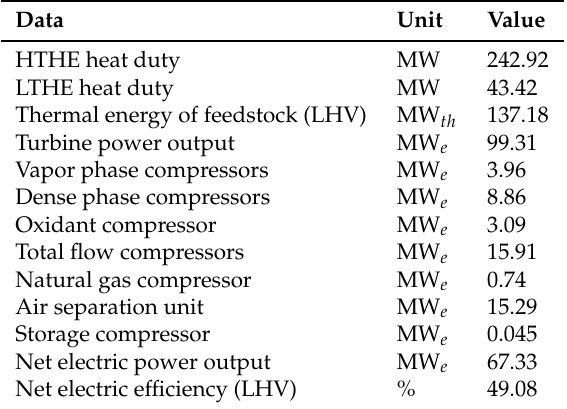
Table 3. Modified cycle performance parameters.